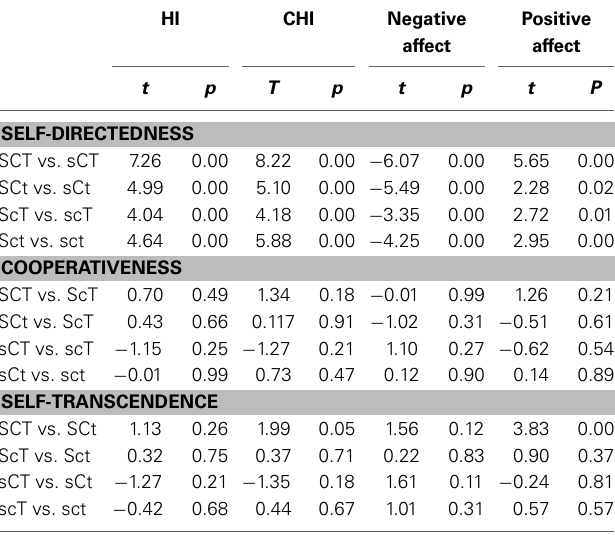
Table 7 | Comparisons between character profiles in standardized to vocational schools. Again, these statistically significant differ- measures of Happiness Index (HI), Composite Health Index (CHI), and ences were small, as suggested by the Effect size, and therefore, negative and positive affect. they need to be considered with CHI Negative Positive affect affect